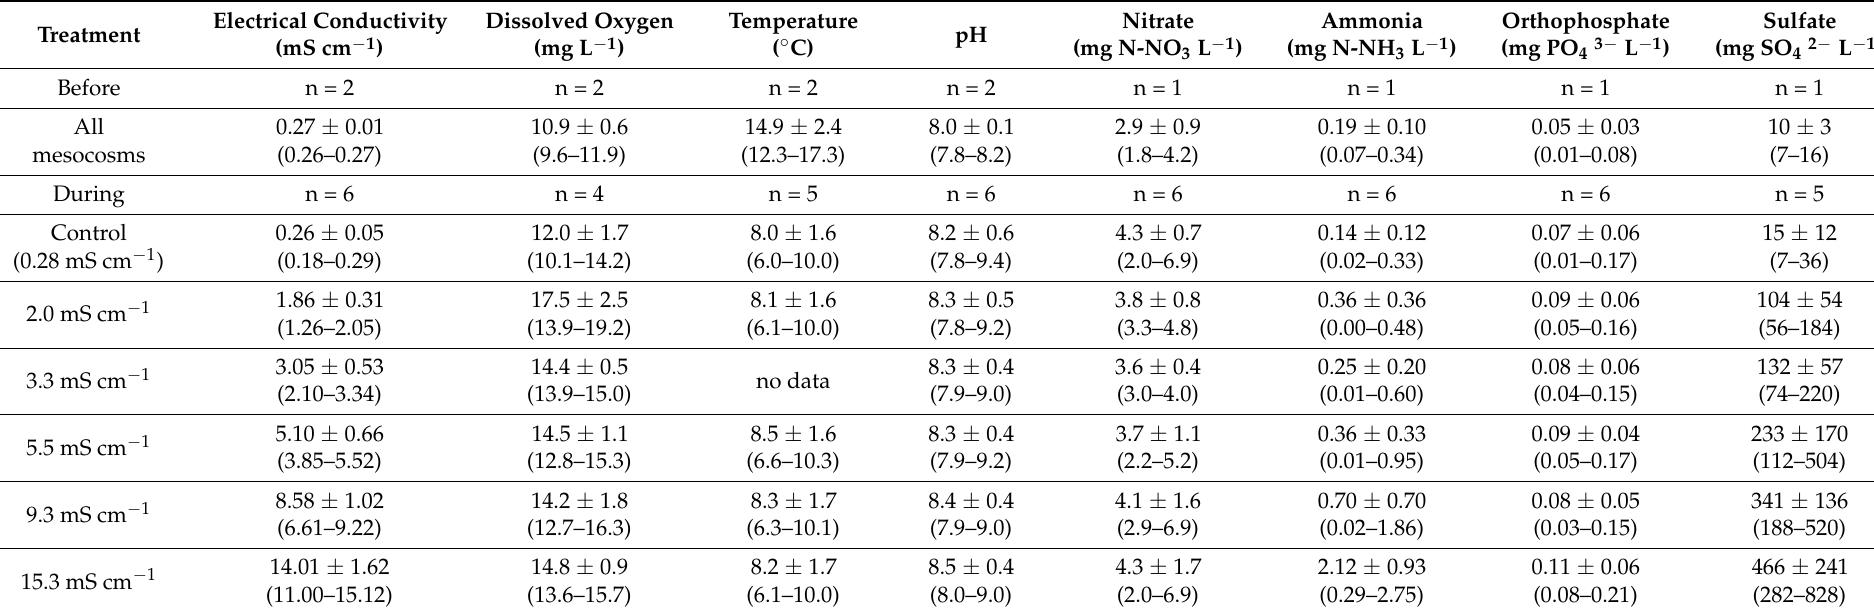
Table 1. Average values ± 1 SD (and range) of water physicochemical characteristics before (one to two measurements per mesocosm) and during the 65 days study period after seawater intrusion (four to six measurements per